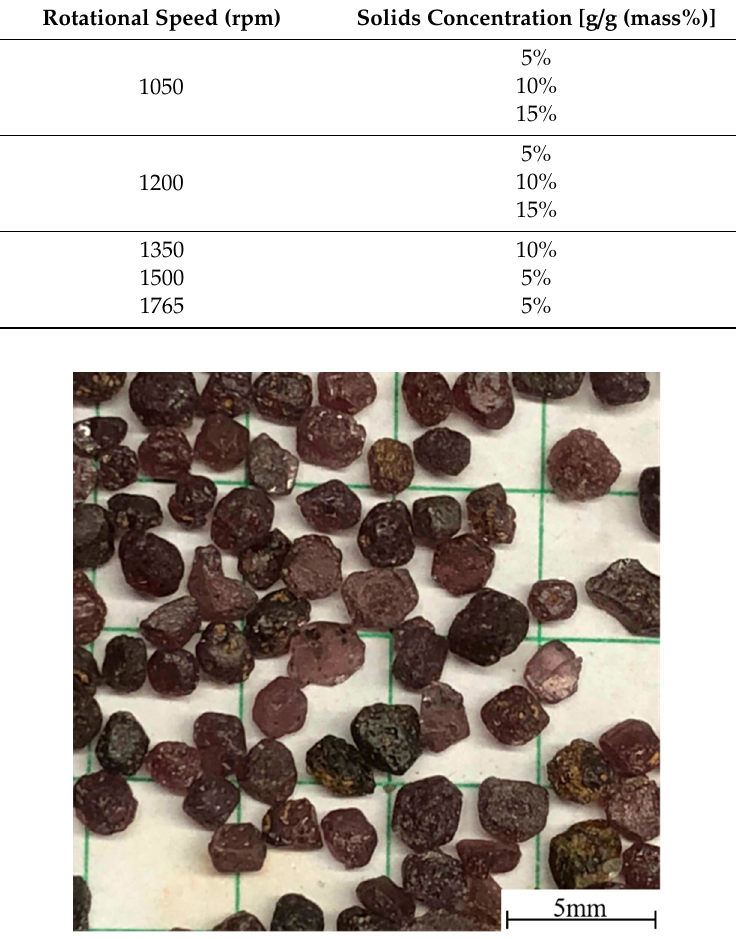
Figure 4. Magnified view of garnets on 5 mm square grid. The garnet size and roundness evolved during experiments so that fresh garnet had to be replaced in the system regularly. The observed rate